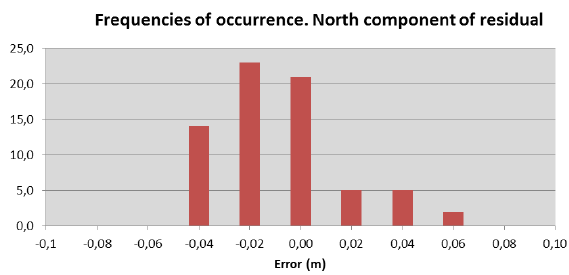
Figure 15. Frequency histogram of the deviations in North component of natural control points positions.